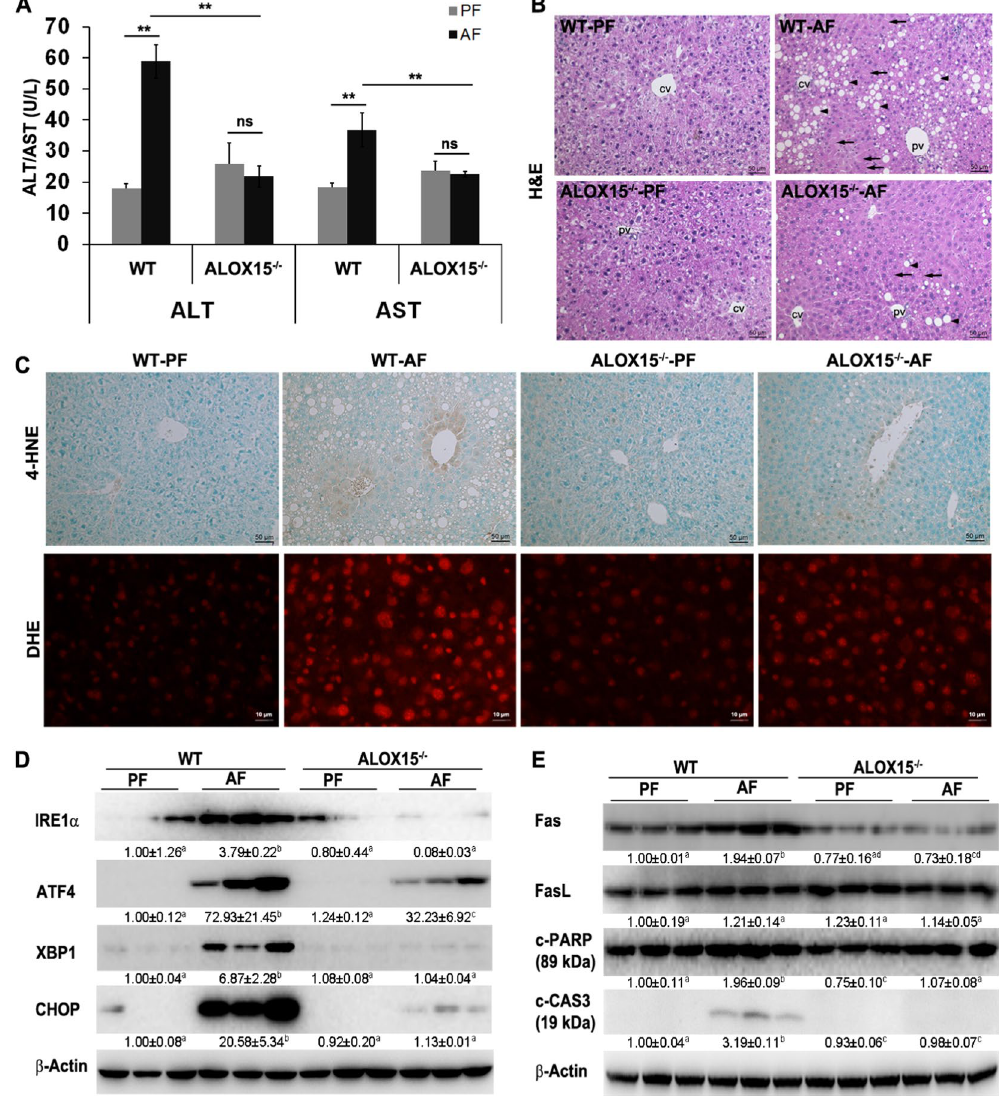
Figure 4. ALOX15 knockout attenuated alcohol-induced liver injury, ROS production, ER stress, and apoptosis. WT and ALOX15 − / − male mice were fed with control (PF) or alcohol (AF) liquid diet for 8 weeks. ( A ) Plasma ALT and AST. ( B ) Liver histopathological changes shown by H&E staining (arrows: necrosis, arrowheads: lipid droplets). ( C ) Representative images of 4-HNE staining (upper panel) and DHE staining (lower panel). ( D ) Immunoblot of proteins involved in ER stress. ( E ) Immunoblot of proteins involved in apoptosis. Protein levels were quantitated by NIH image J. All values are denoted as means ± SD (n = 6 in A, n = 3 in D and E). Significant differences were indicated by different letters (ANOVA, P < 0.05). * P < 0.05, ** P < 0.01, ns, not significant (t-test). H&E: hematoxylin and eosin staining, 4-HNE: 4-hydroxynonenol, DHE: Dihydroethidium, CV: central vein, PV: portal